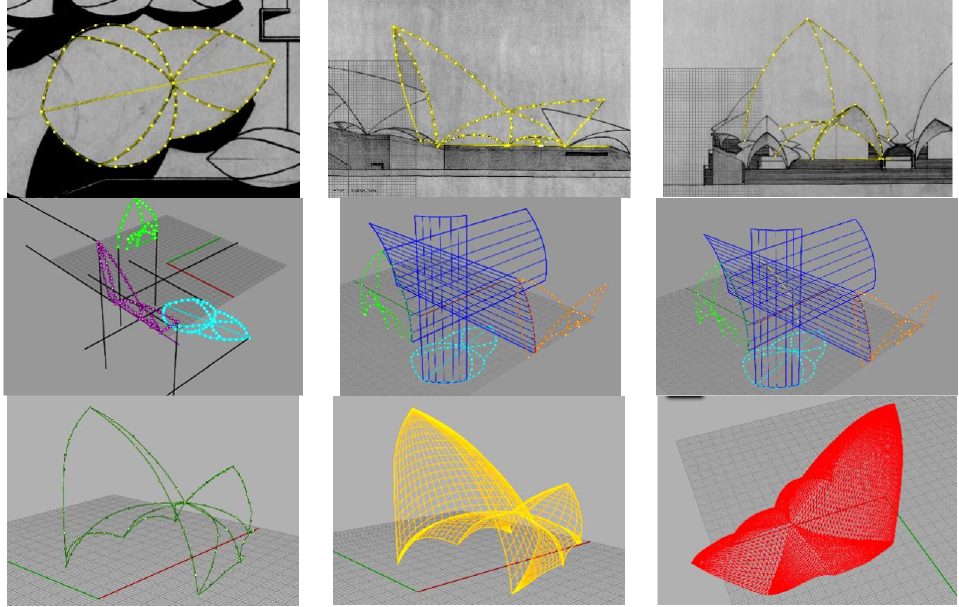
Figure 12. Geometry digitization process: point capture ( top ), edge identification ( center ), and surface and mesh generation ( bottom